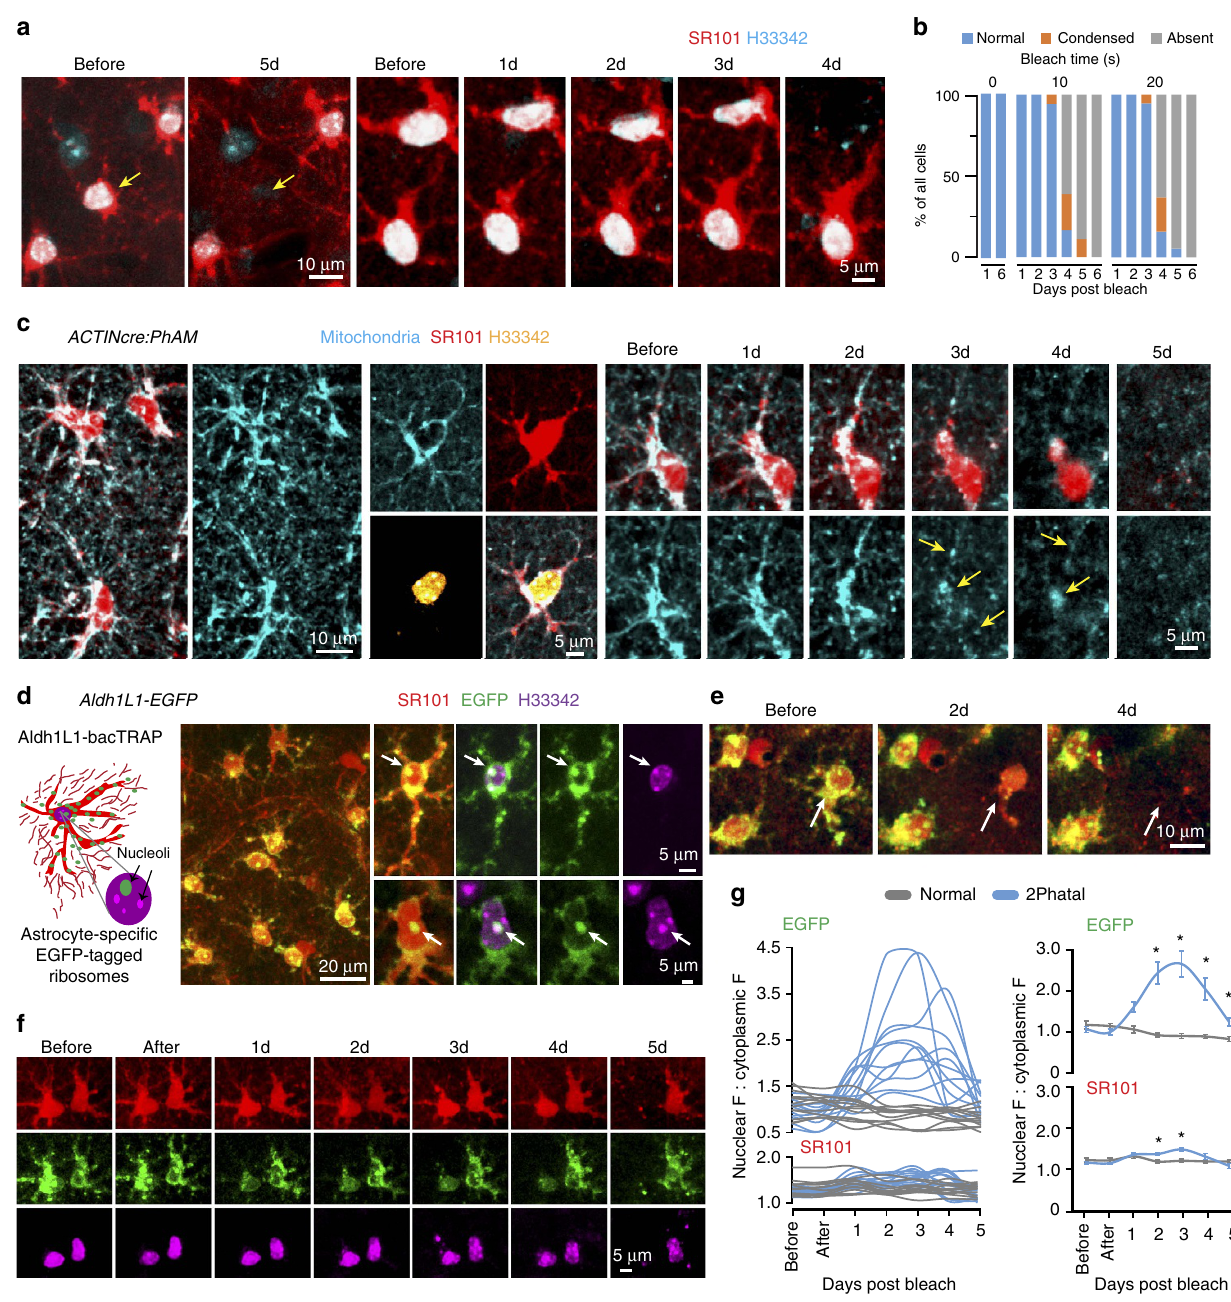
Figure 8 | Delayed apoptosis initiation and early ribosomal disassembly in astrocytes. ( a ) In vivo time-lapse images of SR101-labelled astrocyte (yellow arrows) dying after photobleaching. ( b ) Laser scan time-dependent astrocyte-specific cell death induction 1–6 days after 2Phatal photobleaching, n ¼ 20 cells, 0s control; 18 cells, 10s scan; and 19 cells, 20s scan; from 4 mice. ( c ) SR101-labelled astrocytes showing mitochondrial fission (yellow arrows) occurring 3–4 days after initial photo bleaching. ( d ) Schematic showing EGFP targeting to astrocyte ribosomes in Aldh1L1 -EGFP bacTRAP transgenic mice and in vivo images of SR101-labelled astrocytes with EGFP-labelled ribosomes in the cytoplasm and nucleoli (arrows). ( e ) Imaging of a single astrocyte (arrow) showing maintenance of SR101 labelling 2 days after photobleaching, whereas EGFP-L10a fluorescence labelling is markedly reduced. ( f ) In vivo time-lapse sequence showing loss of EGFP-L10a label in a single astrocyte 1 day after photobleaching, whereas SR101 labelling remains until the day of nuclear condensation and cell death progression. ( g ) Quantification of the nuclear and cytoplasmic fluorescence intensity ratios for EGFP-L10a and SR101 at sequential days after photobleaching showing both single cell traces and grouped data with mean ± s.e.m., two-way analysis of variance with Bonferroni post hoc comparing EGFP-L10a in normal vs 2Phatal for days 1–5 after bleaching n ¼ 12 cells for each condition from 3 mice. GFP: before; P 4